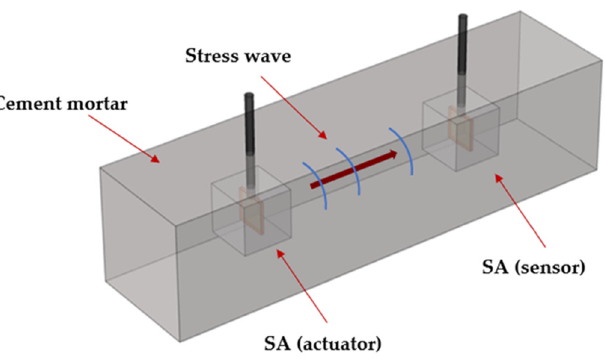
Figure 1. The configuration of the piezoelectric sensing system in the cement mortar test